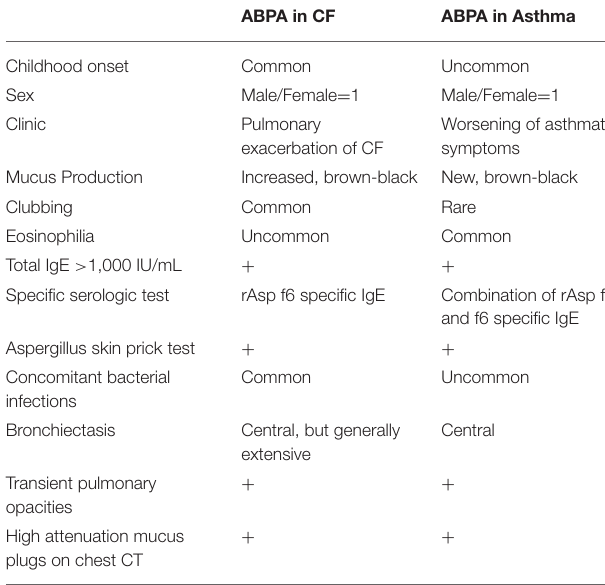
TABLE 6 | Similarities and differences of ABPA in patients with cystic fibrosis or